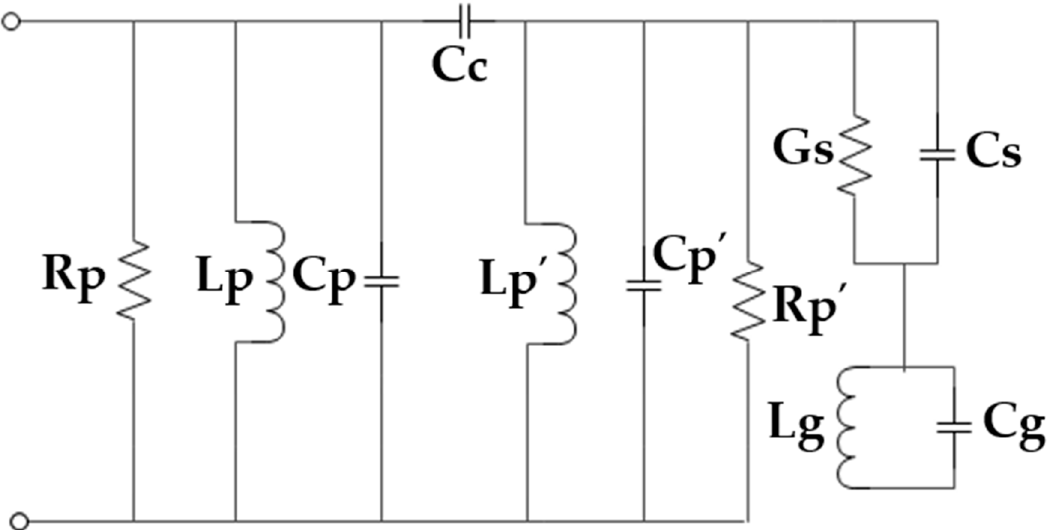
Figure 12. The complete lumped element circuit of the proposed antenna.